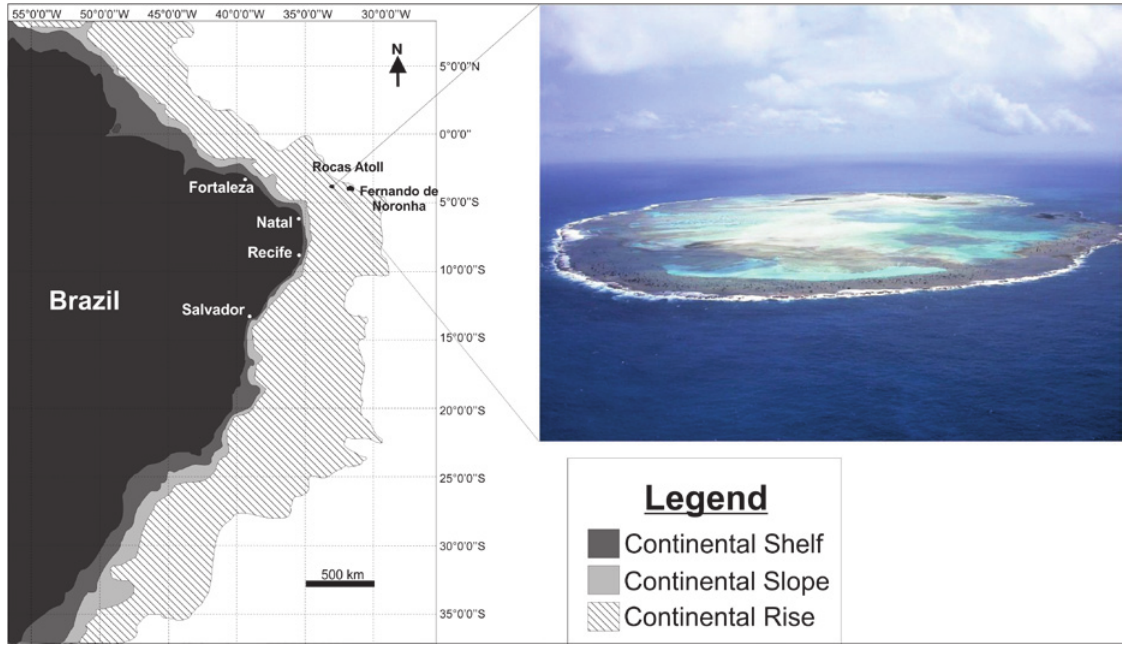
Figure 01 - Location of the Rocas Atoll. Photo: aerial picture from Rocas, viewed from southward. Source: ICMBio